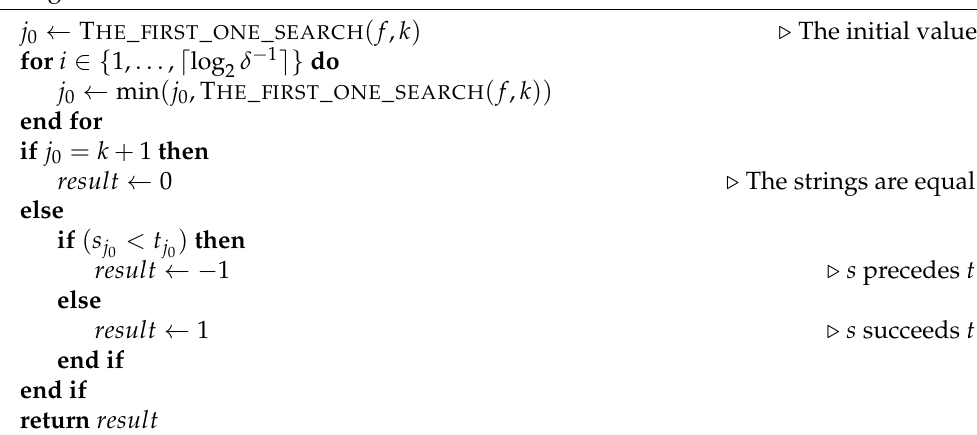
Algorithm 1 C OMPARE _ STRINGS ( s , t , k ) . The Quantum Algorithm for Comparing Two